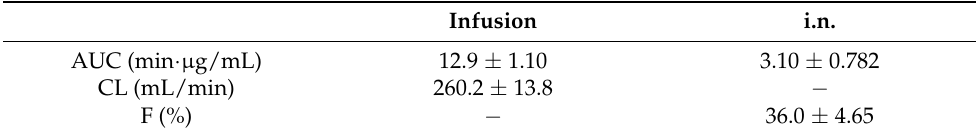
Table 1. Pharmacokinetic parameters of ANA-TA9.